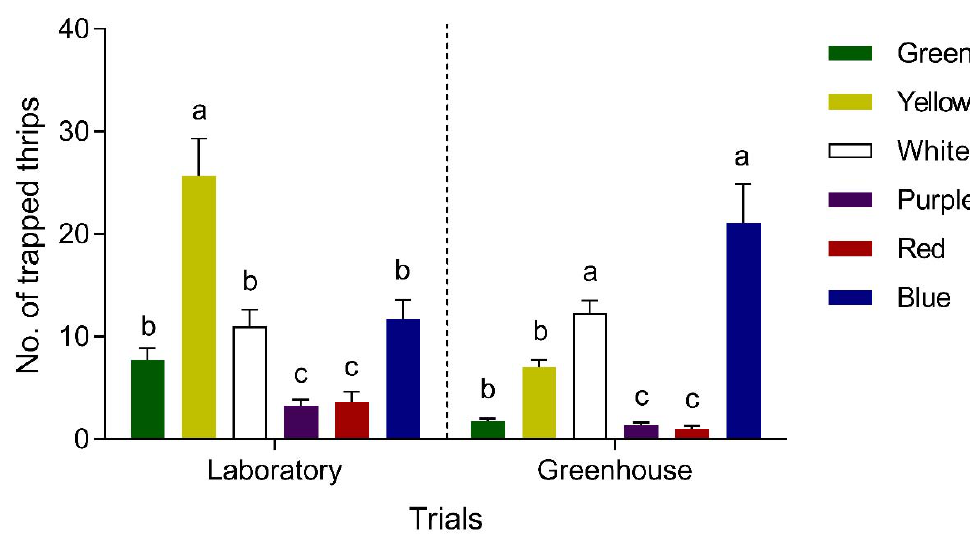
Figure 4. Color preferences by western flower thrips, Frankliniella occidentalis in the laboratory and greenhouse. Different lowercase letters indicate significantly different preferences by thrips to different colors (Tukey’s HSD test, p < 0.05).